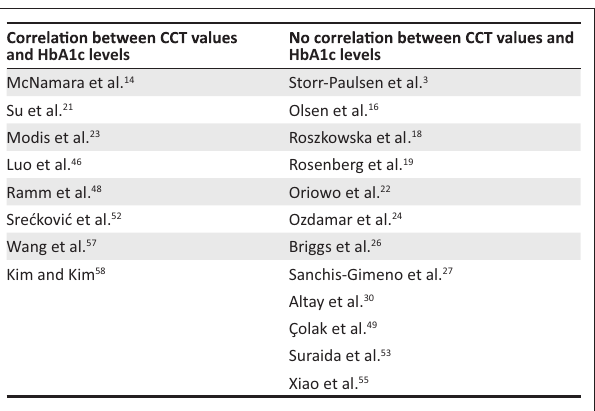
FIGURE 3: A comparative table showing studies that observed a positive correlation between central corneal thickness values and HbA1c levels versus those that did